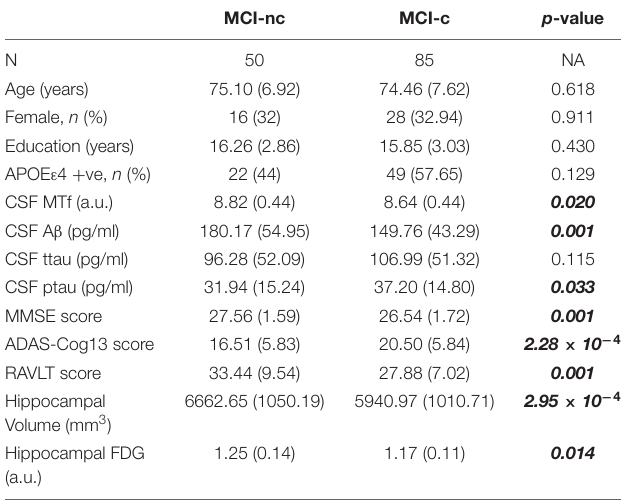
TABLE 2 | Demographics of MCI subjects based on their conversion status: MCI non-converters (MCI-nc) and converters (MCI-c) to AD. MCI-nc